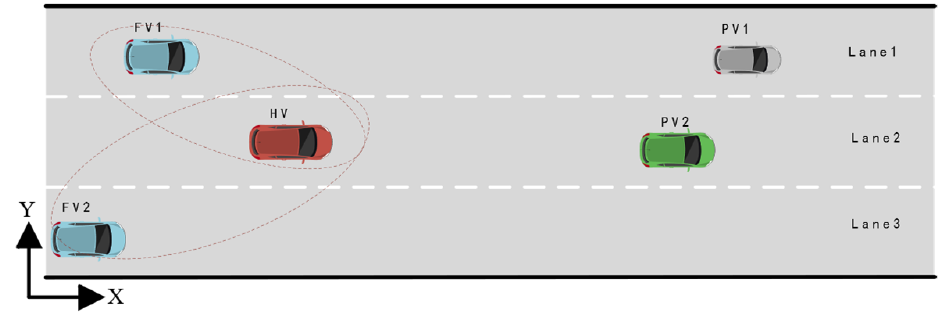
Figure 12. Testing Scenario B.